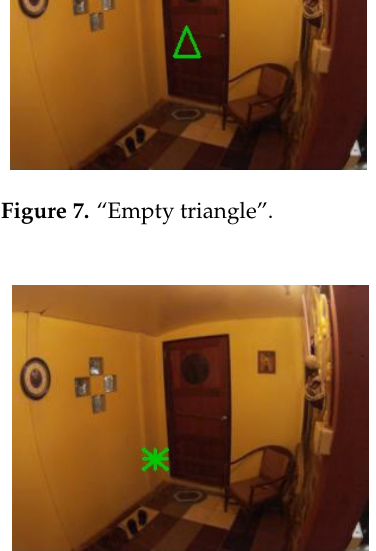
Figure 8. “Star of thickness 2”.